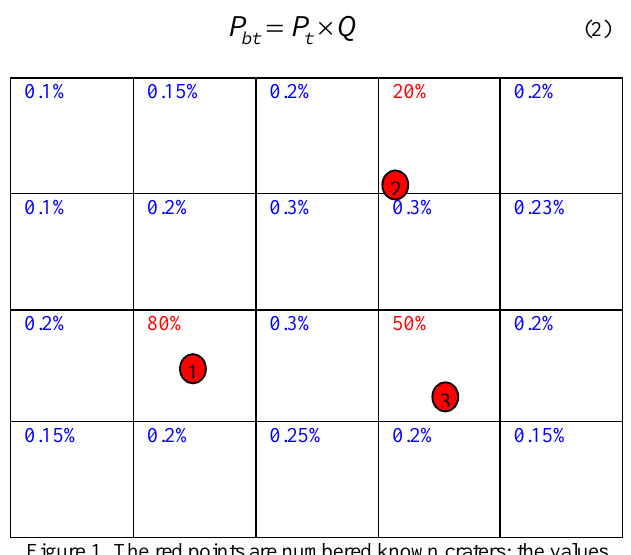
Figure 1. The red points are numbered known craters; the values in percent are calculated dud probability according to distance parameter. Inclusion of known craters resulted in unreasonable